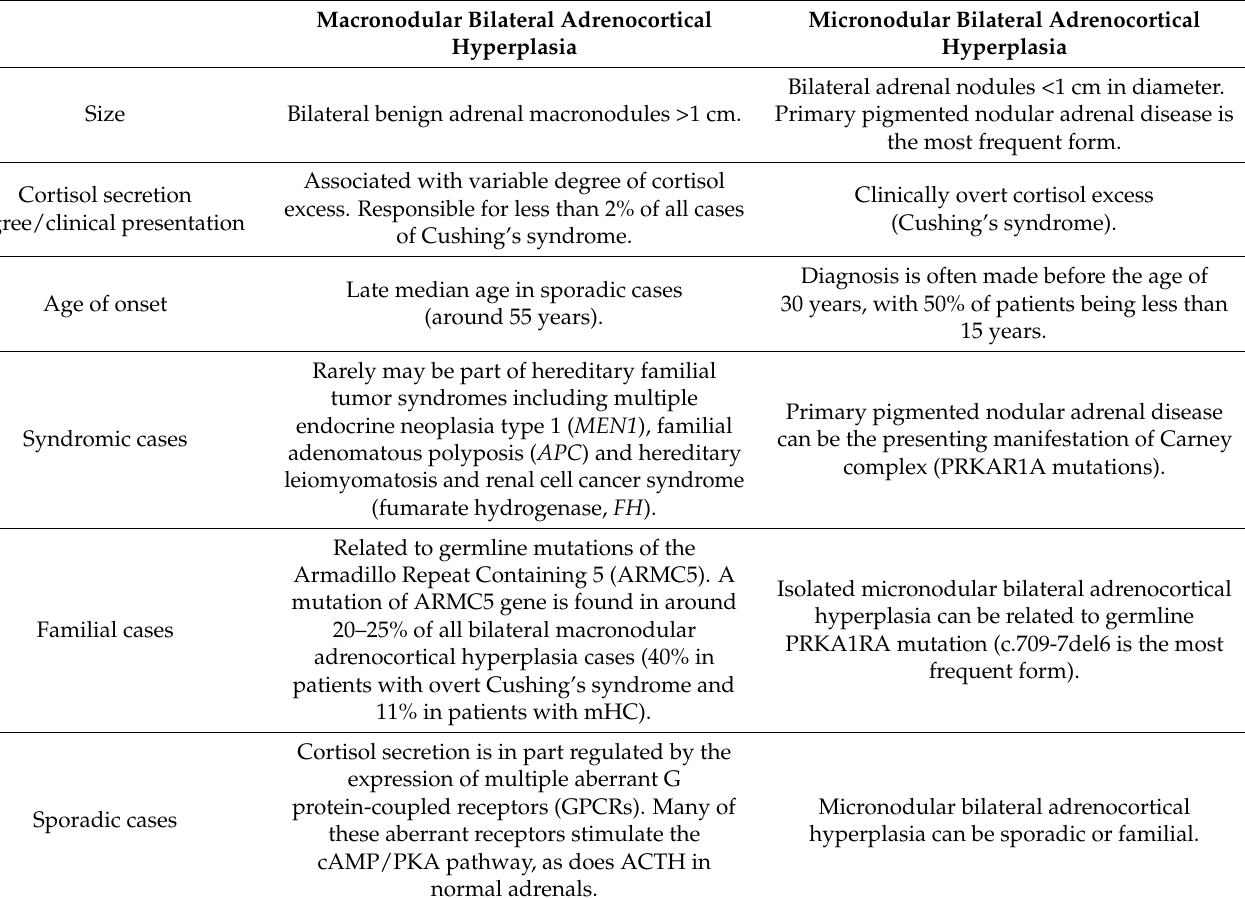
Table 2. Comparison between macronodular and micronodular bilateral adrenocortical hyperplasia. Macronodular Bilateral Adrenocortical Micronodular Bilateral Adrenocortical Hyperplasia